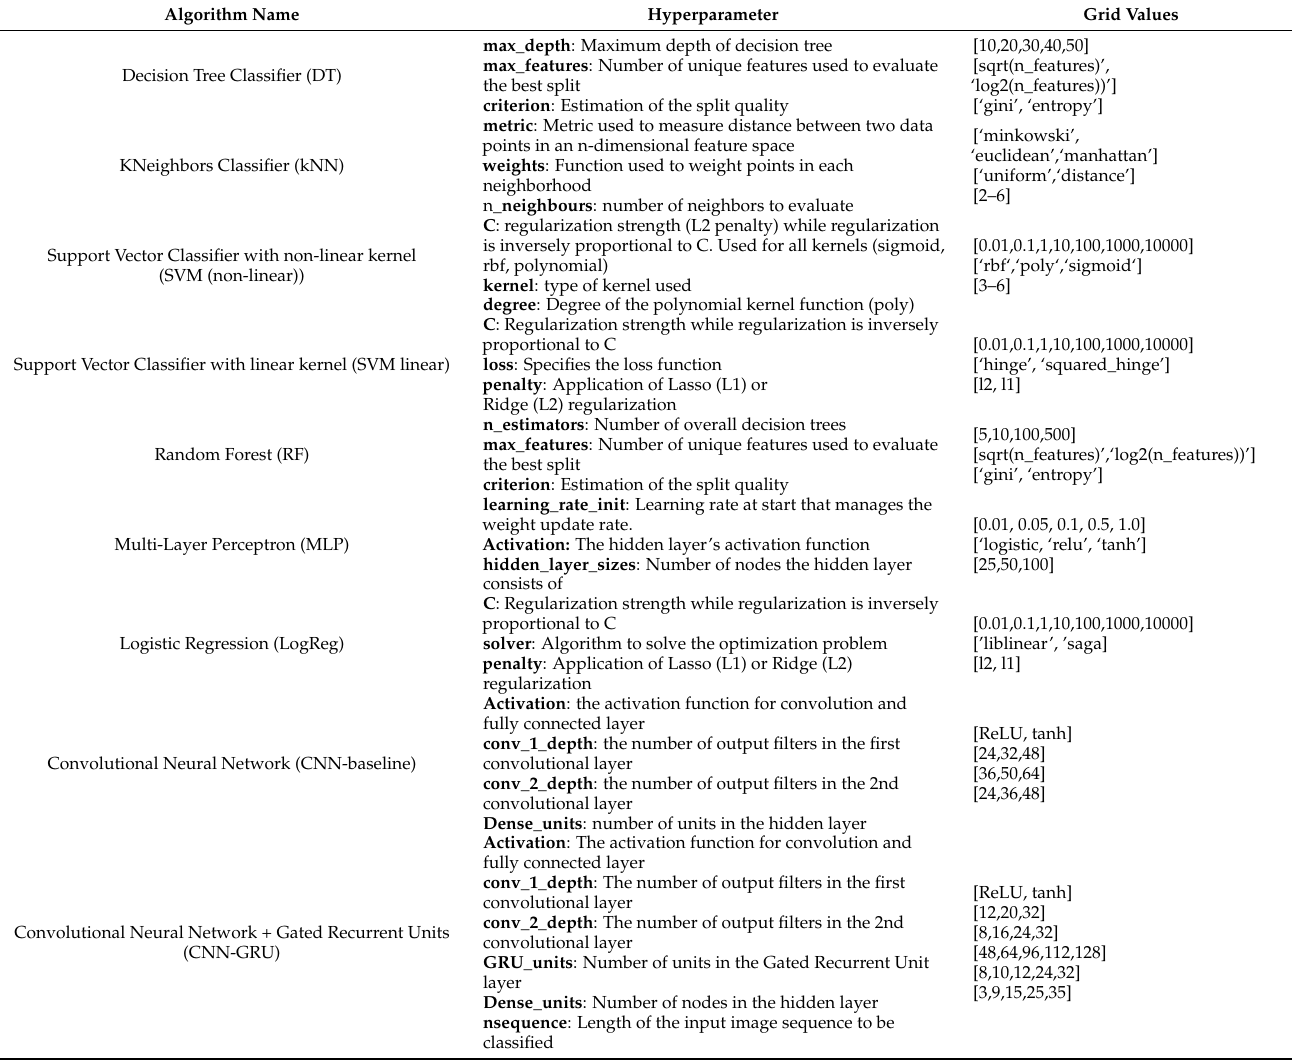
Table A3. Classification algorithms and hyperparameter values used for cross-validated (nested) grid